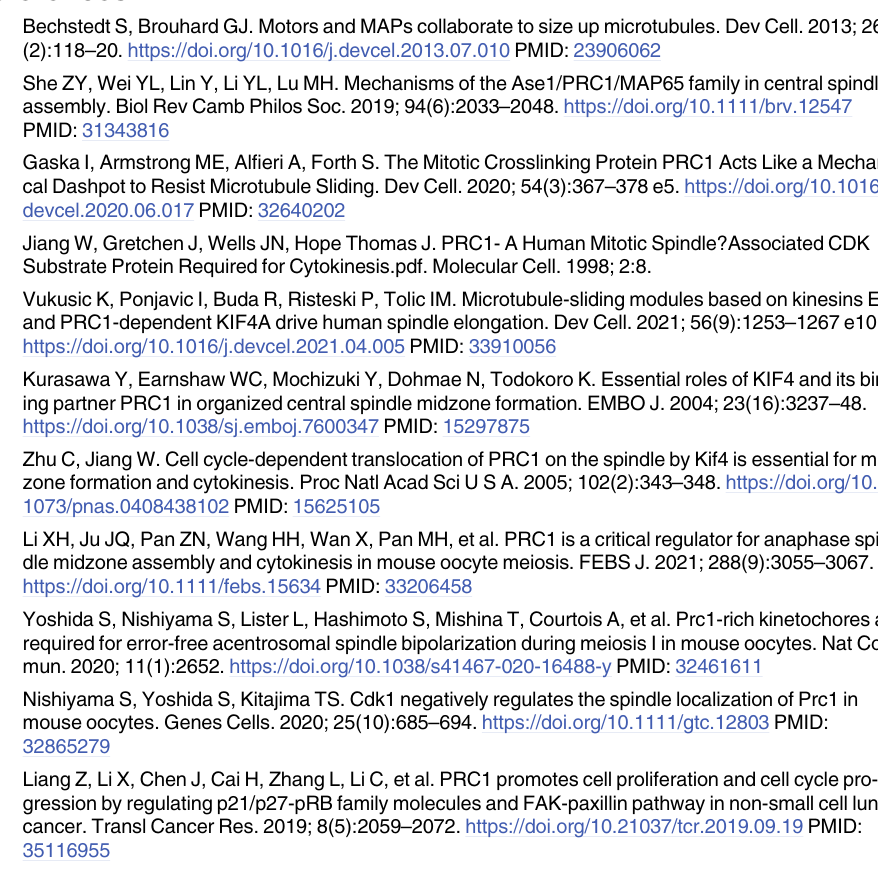
S6 Table. Table showing RDC alignment tensors of PRC1-DD (generated by software PALES). S7 Table. Table showing the SAXS data processed by different softwares, the SAXS data was collected with protein concentration of 10mg/ml for 8h, PV is for porod